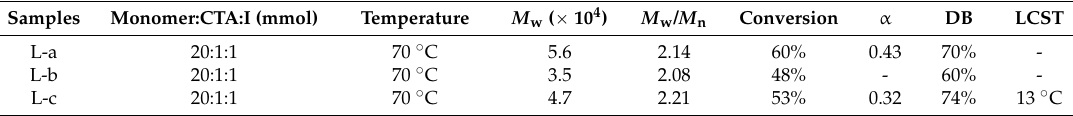
Table 1. The parameters of HPMAM, HPNPAM and HPNBAM.